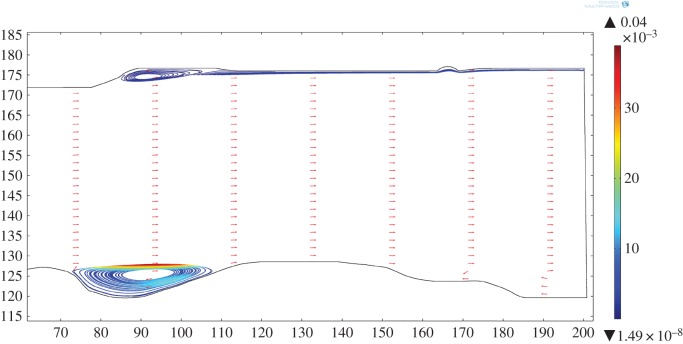
Extended view of model showing eddies at top and bottom of the intrusion. Single particle, density 2500 kg m−3 (plagioclase) magma viscosity 10 Pa s. Note some particles escaping from upper eddy back into the flow. Arrows show fluid velocity field. Reynolds number = 5800.